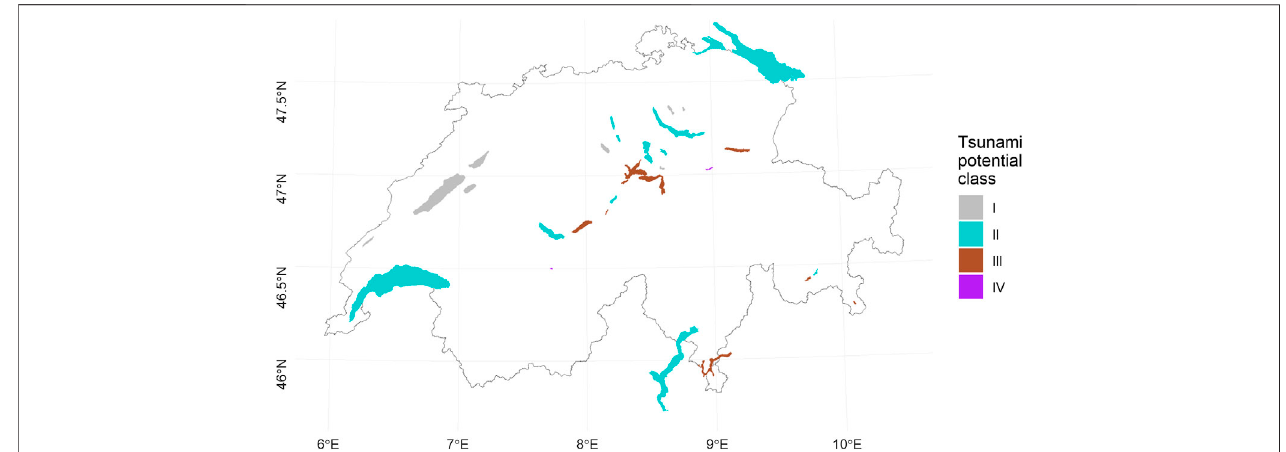
FIGURE 4 | Spatial distribution of the lakes colored according to the identi fi ed main tsunami source classes.